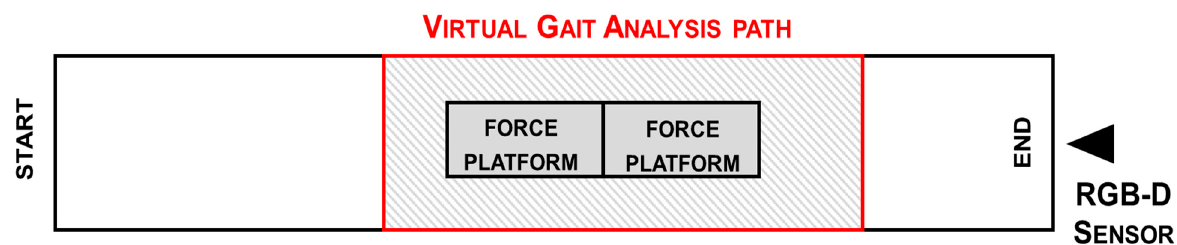
Figure 2. Scheme of the experimental setup: position of RGB-D sensor and gait analysis path (red) inside the walkway to ensure total body motion capture and analysis.